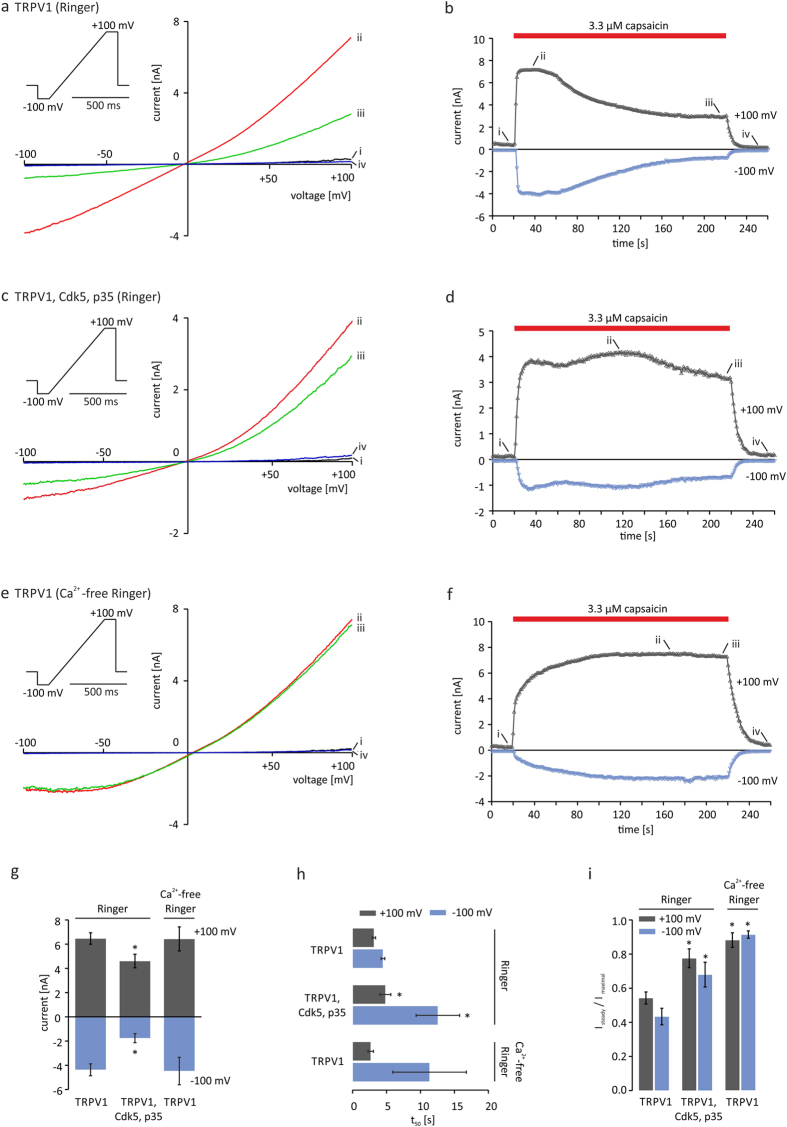
Cdk5-mediated phosphorylation of TRPV1 prevents desensitization to capsaicin.TRPV1-mediated inward (−100 mV) and outward (+100 mV) currents in transiently transfected CHO cells induced by 3.3 μM capsaicin in the presence or absence of extracellular Ca2+. Left panels show I/V relationships corresponding to the representative recording traces on the right. In the presence of extracellular Ca2+, application of capsaicin for 200 s established a desensitized steady state in TRPV1 expressing cells (a,b). Co-expression of TRPV1, Cdk5-mCherry and p35-CFP inhibits the Ca2+-induced desensitization (c,d), similar to the capsaicin-induced currents of TRPV1 in absence of extracellular Ca2+ (e,f). Maximal induced currents (g), time to half-maximal response represented as t50 (h) and desensitization as ratio Isteady/Imaximal (i) of n = 11–22 independent measurements. Asterisk (*) indicates significant differences compared to the corresponding TRPV1 value at Ca2+-containing conditions (unpaired WR-test, p < 0.05).